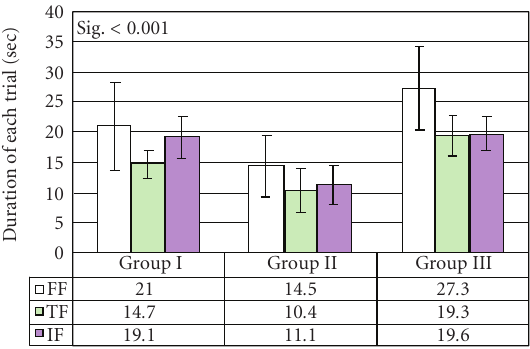
Figure 12: Duration of each